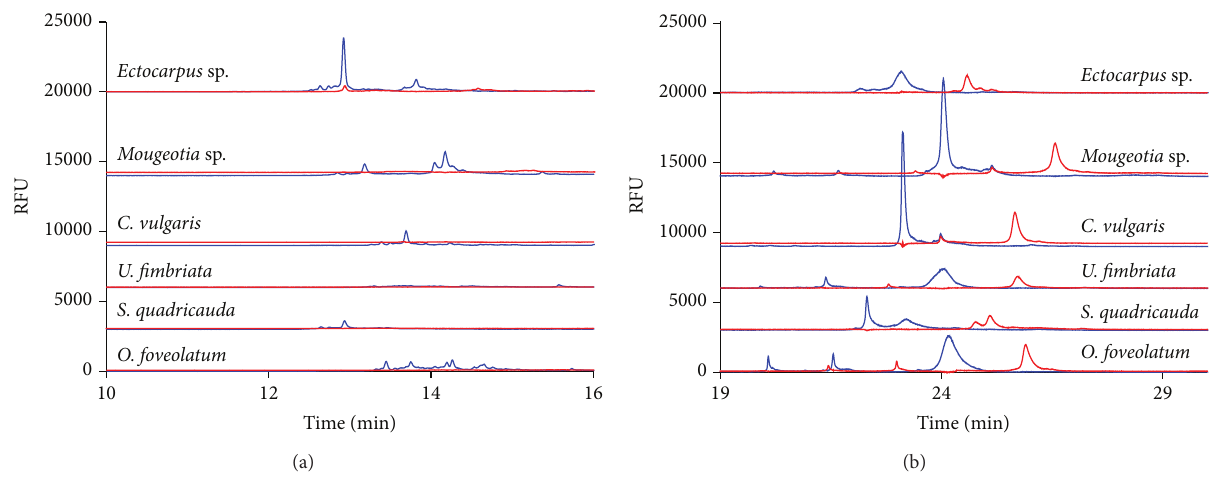
Figure 3: Detection of the (a) early and (b) later migrating peaks formed from the 18S rDNA variable region 7 as detected by CE-SSCP for green and brown algae. Forward or sense strands are represented in blue while reverse or antisense strands are represented in red.